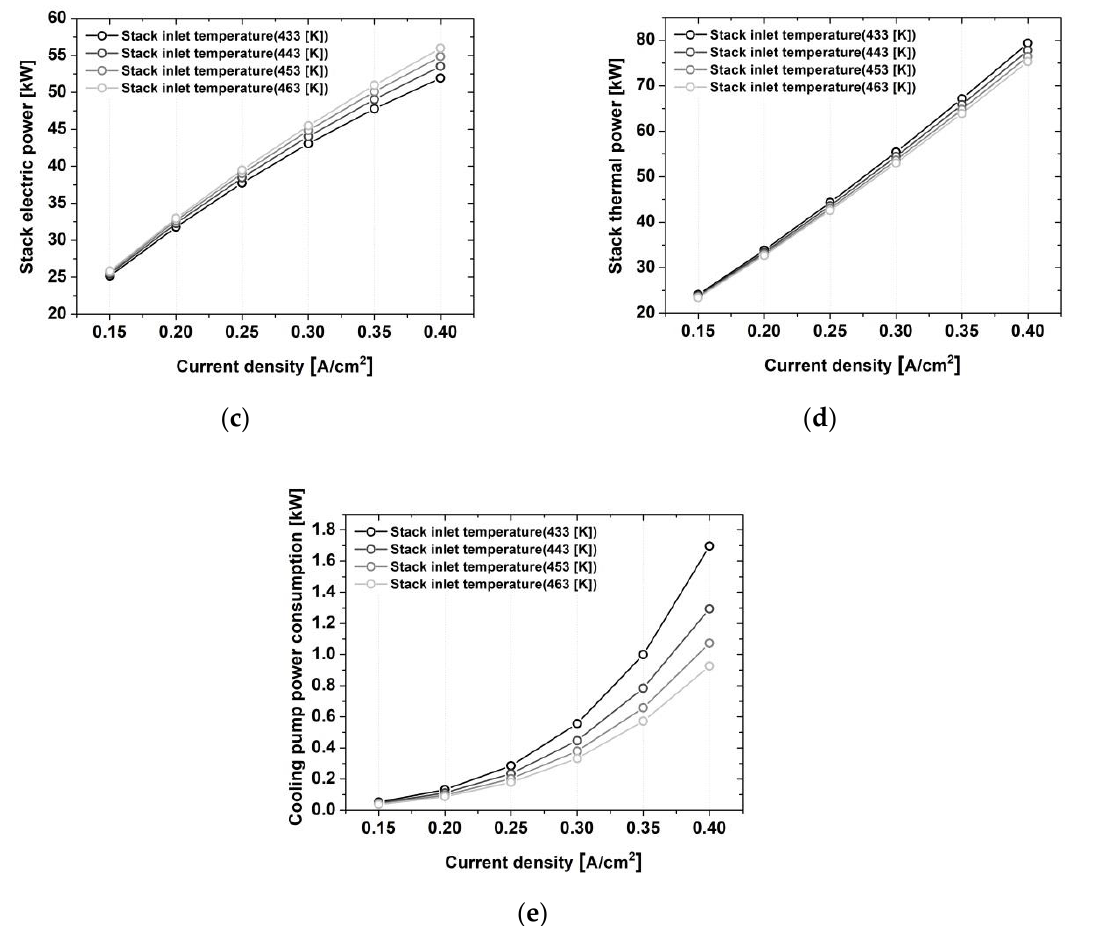
Figure 9. Validation trends of system performance with stack inlet temperature. ( a ) Combined system and stack power efficiency; ( b ) ORC net power; ( c ) Stack electric power; ( d ) Stack thermal power; ( e ) Cooling pump power consumption.